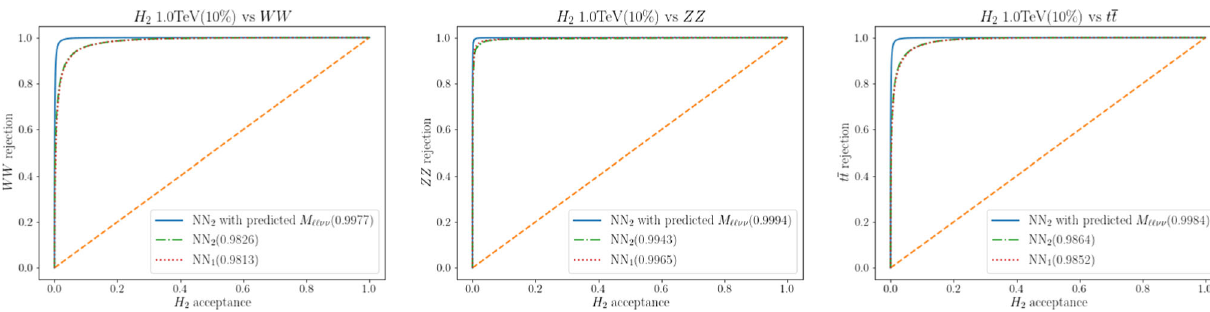
Fig. 10 TheROCcurvesofa1TeVHiggs(with (cid:10) H / m H = 0 . 1)signalagainstthebackgroundclasses, WW , Z Z ,and t ¯ t .Inlegends,inparenthesis, we show the AUC corresponding the first classifier, NN 1 , and the second classifier, NN 2 , with and without including the predicted mass